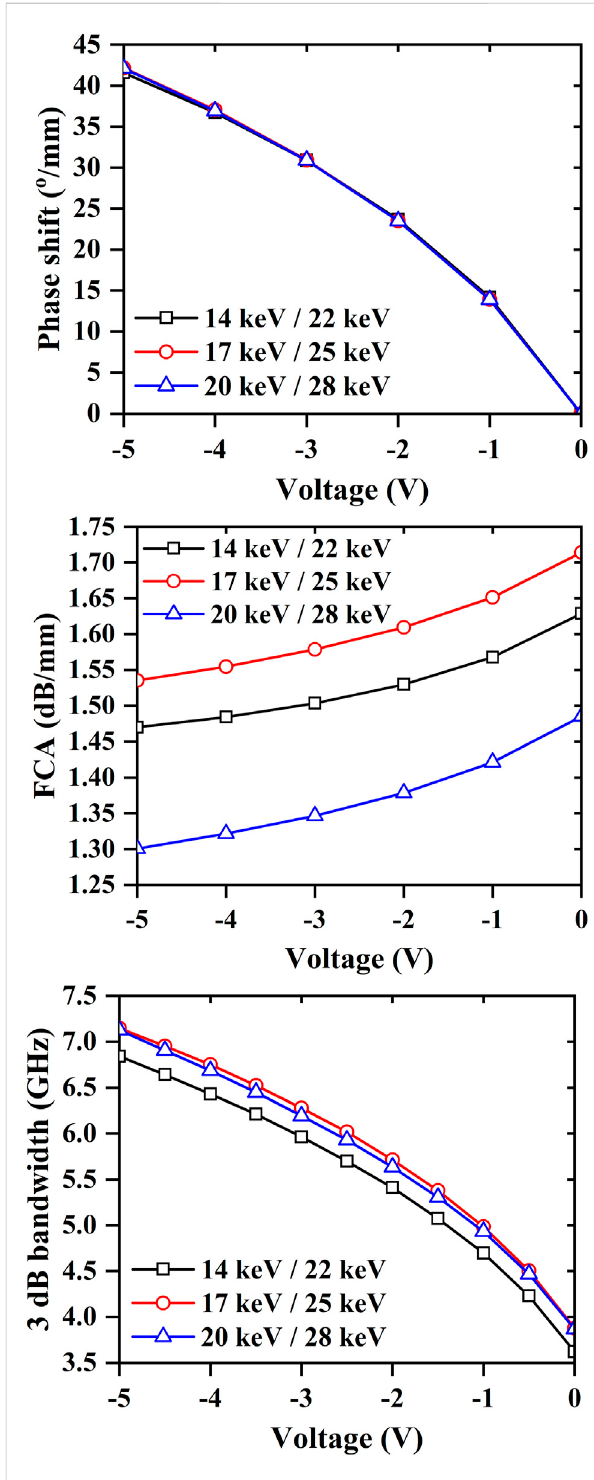
FIGURE 3 (A) Phase shift per unit length, (B) free-carrier absorption per unit length, and (C) 3-dB bandwidth for different implantation doses. The boron and phosphorus implantation dose is equal for each sample.